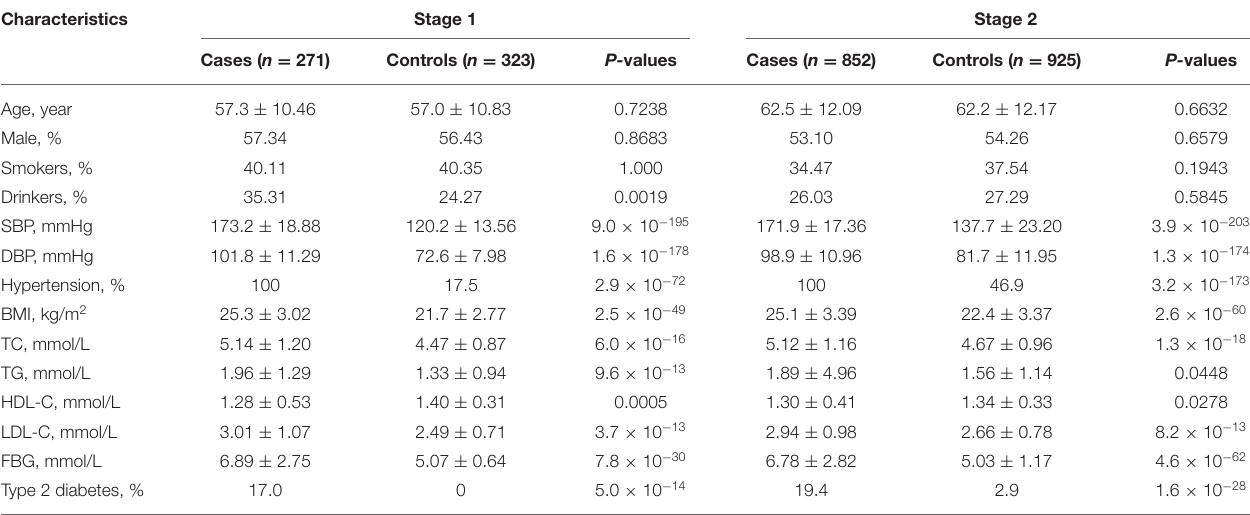
TABLE 1 | Characteristics of the ischemic stroke cases and controls.